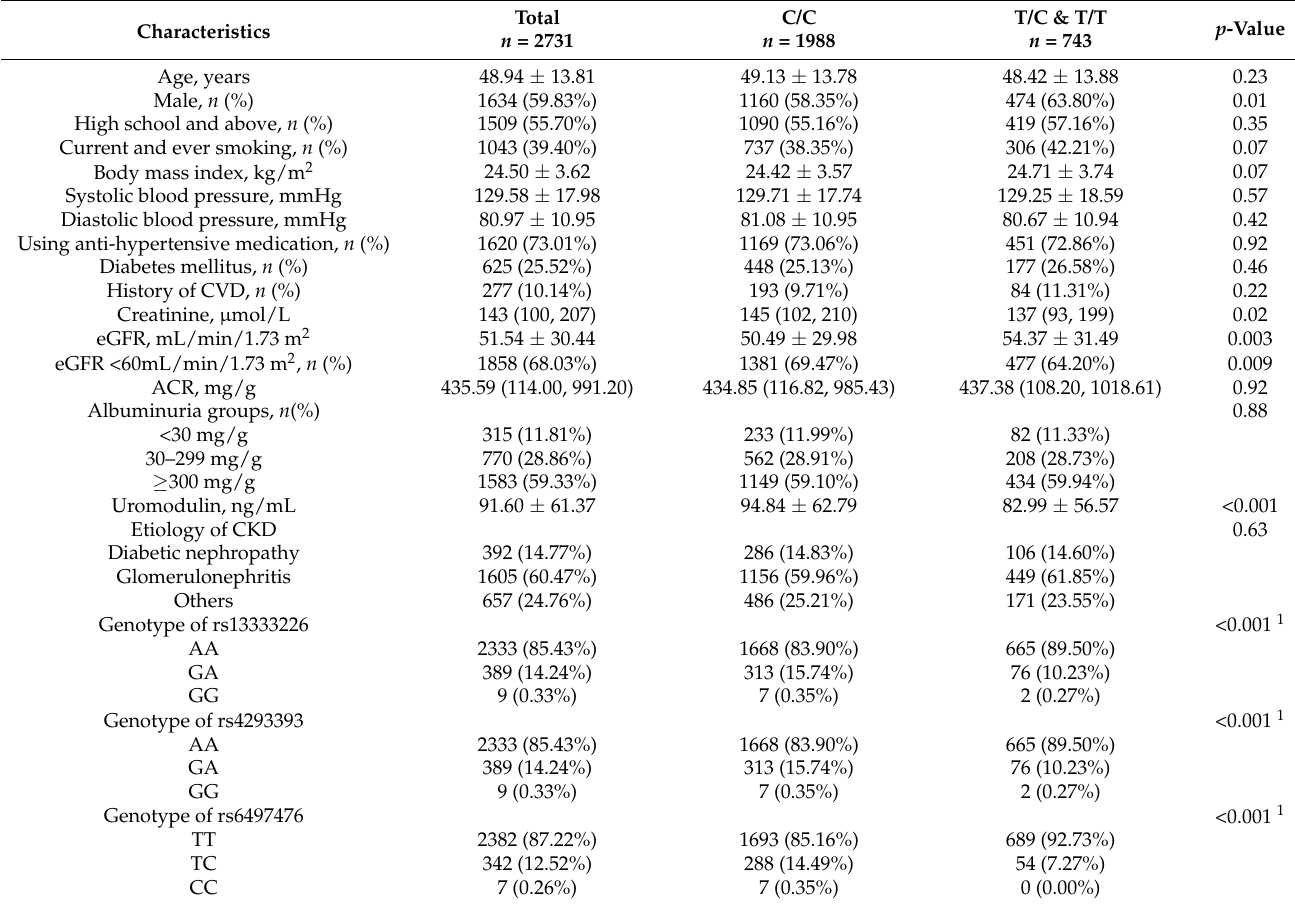
Table 1. Characteristics of study participants stratified by genotypes of rs11864909.